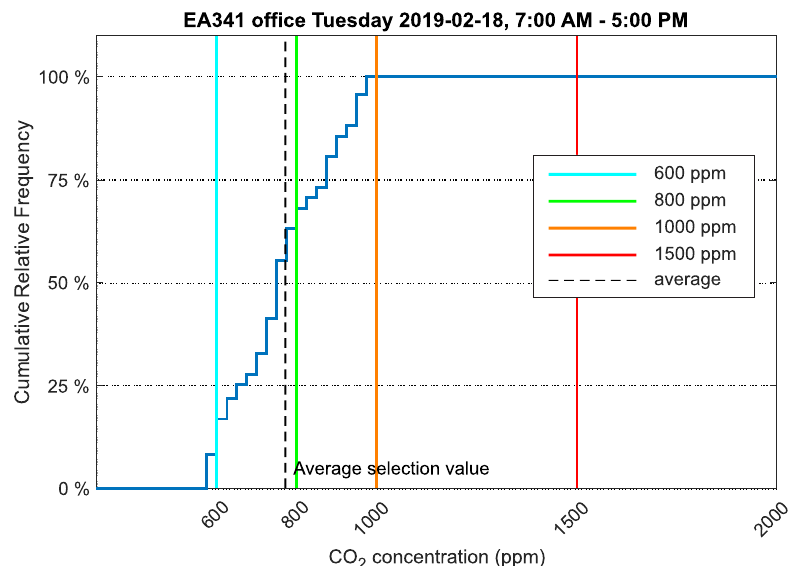
Figure 11. Cumulative relative frequency graph of the data selection showing CO 2 concentration in office EA341, VŠB-TUO.